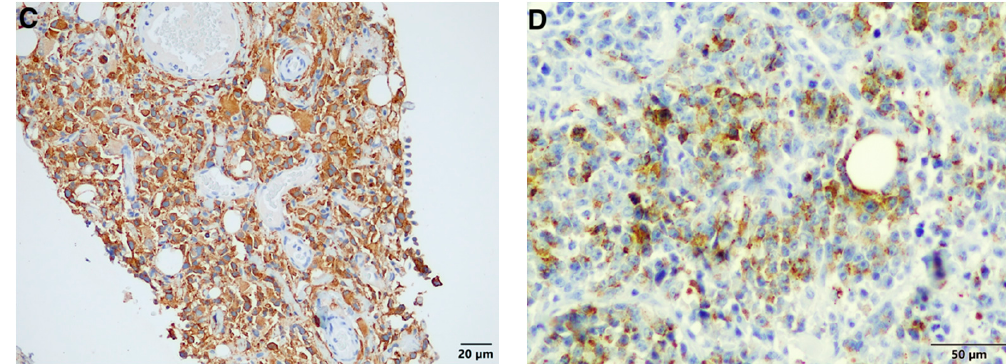
Figure 4. Positive PNL-2-specific labelling of the neoplastic cells in the ( A ) skin, ( B ) liver, and ( C ) omentum. ( D ) Positive PNL-2 control.